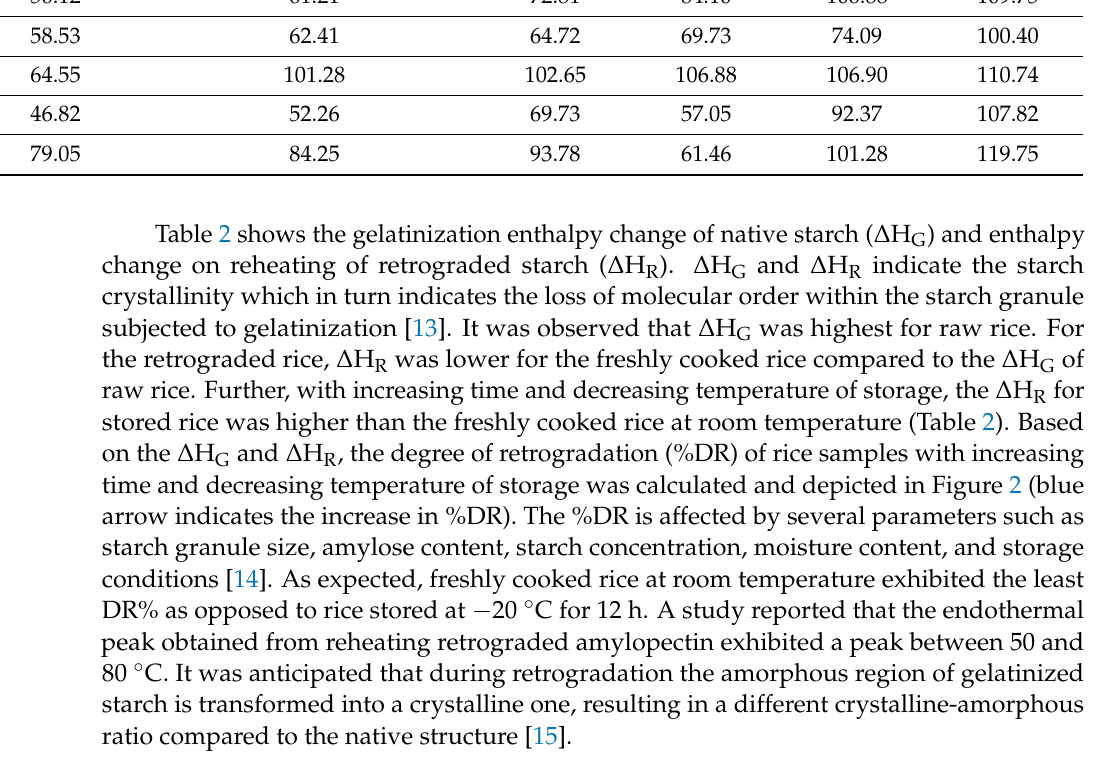
Table 2. Gelatinization enthalpy change of native starch ( ∆ H G ) and enthalpy change on reheating of retrograded starch ( ∆ H R ) for rice